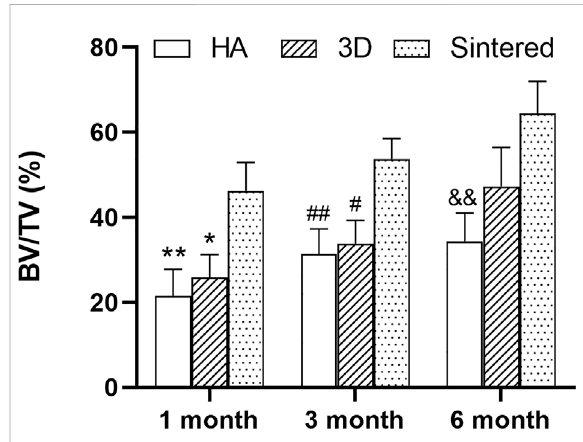
FIGURE 6 BV/TV analysis of three materials at different times. * p < 0.05whencomparing3Dgroupandsinteredporoustitaniumalloy group at 1 month; ** p < 0.01 when comparing HA group and sinteredporoustitaniumalloyat1 month; # fn# p < 0.05when comparing 3D group and sintered porous titanium alloy group at 3 months; ## fn## p < 0.01whencomparingHAgroupandsintered porous titanium alloy group at 3 months; && fnamp p < 0.01 when comparing HA group and sintered porous titanium alloy group at 6 months.